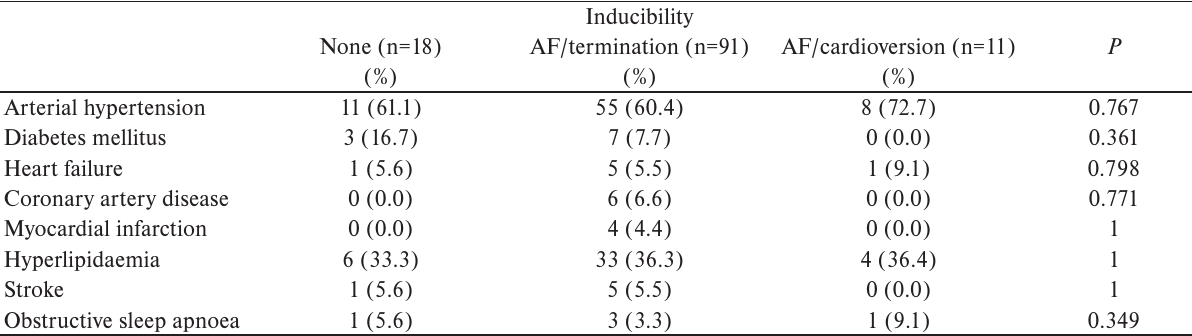
Table 6. The difference in baseline clinical parameters before ablation in patients according to